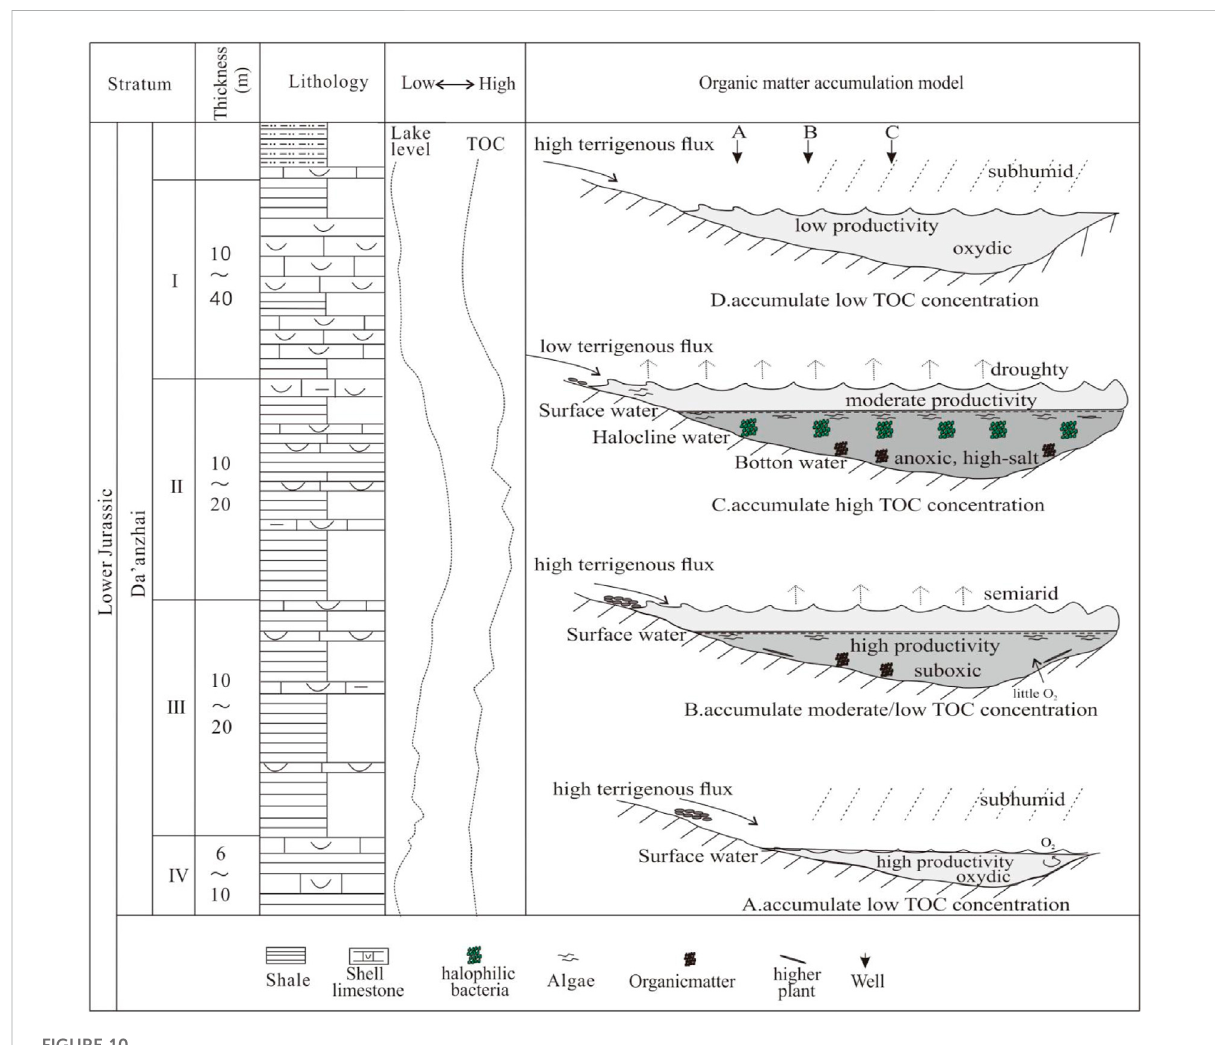
FIGURE 10 Organic matter enrichment pattern of the Da ’ anzhai member in Sichuan